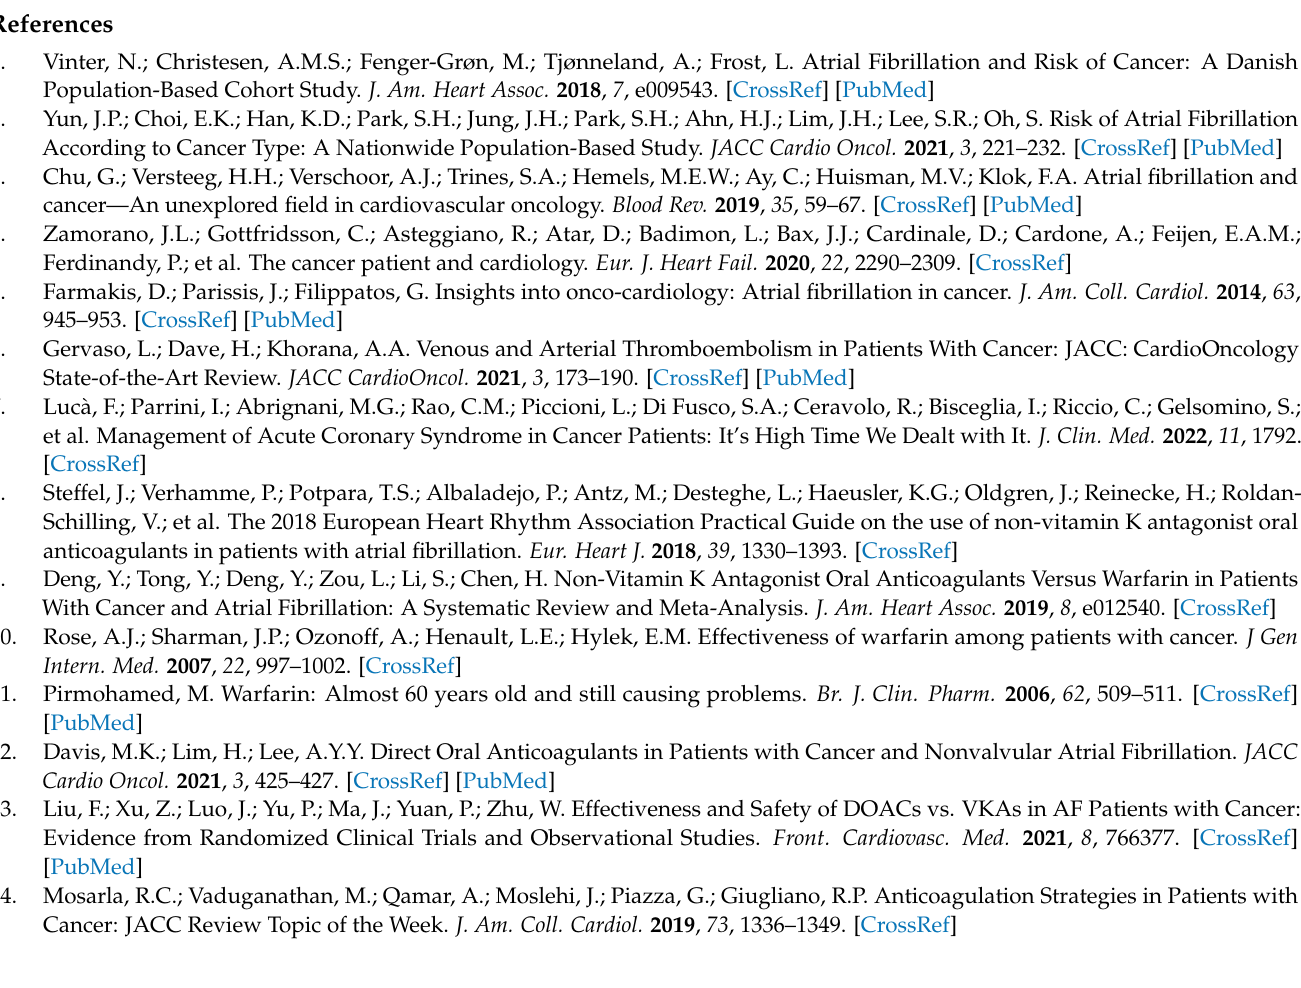
outcomes, Figure S2: Forest plots of efficacy and safety outcomes in active cancer only patients, Figure S3: Funnel plots of efficacy and safety outcomes in active cancer only patients, Figure S4: Forest plot of efficacy and safety outcomes without the study by Sawant et al, Figure S5: Funnel plot of efficacy and safety outcomes without the study by Sawant et al, Figure S6: Forest plot of efficacy and safety outcomes without the study by Sawant et al. in active cancer only patients, Figure S7: Funnel plot of efficacy and safety outcomes without the study by Sawant et al. in active cancer only patients, Table S1: Dosages of DOACs and VKAs, Table S2: Patient thrombotic and hemorrhagic risk: Table S4: Quality